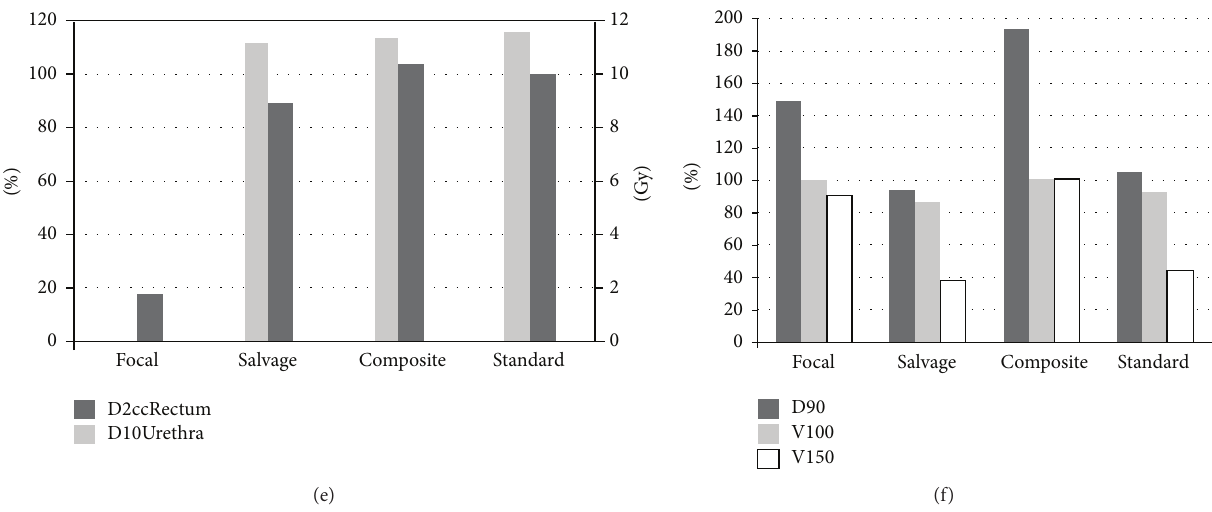
Figure 2: Organ/isodose contours, DVH for focal plan (a), salvage plan (b), composite of focal plan and salvage plan (c), and standard whole gland plan (d) of ideal focal HDR patient. Isodose lines are as follows: Black 450 cGy, Magenta 750 cGy, Green 1275 cGy, Cyan 1500 cGy, Orange 1875 cGy, Dark Pink 2250 cGy, and Yellow 3000 cGy. Target (e) and organ at risk doses (f).